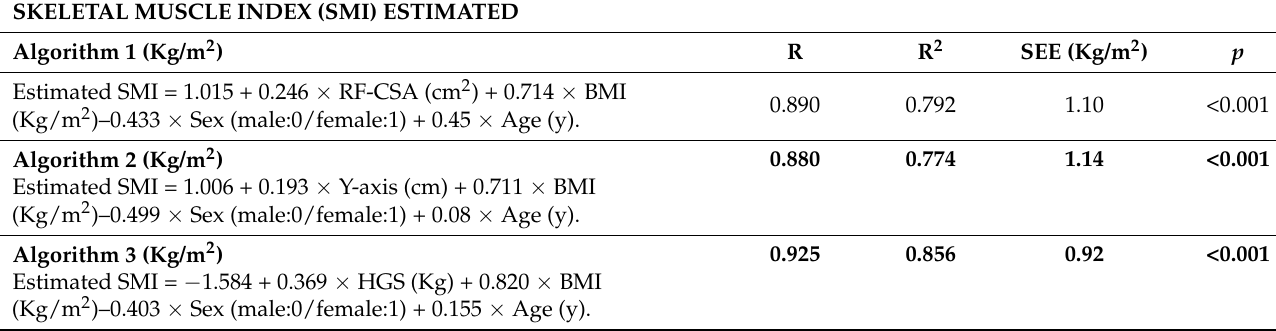
Table 4. Skeletal muscle index (SMI) estimated algorithms as criteria for sarcopenia based on ultrasound assessment of rectus femoris (RF).